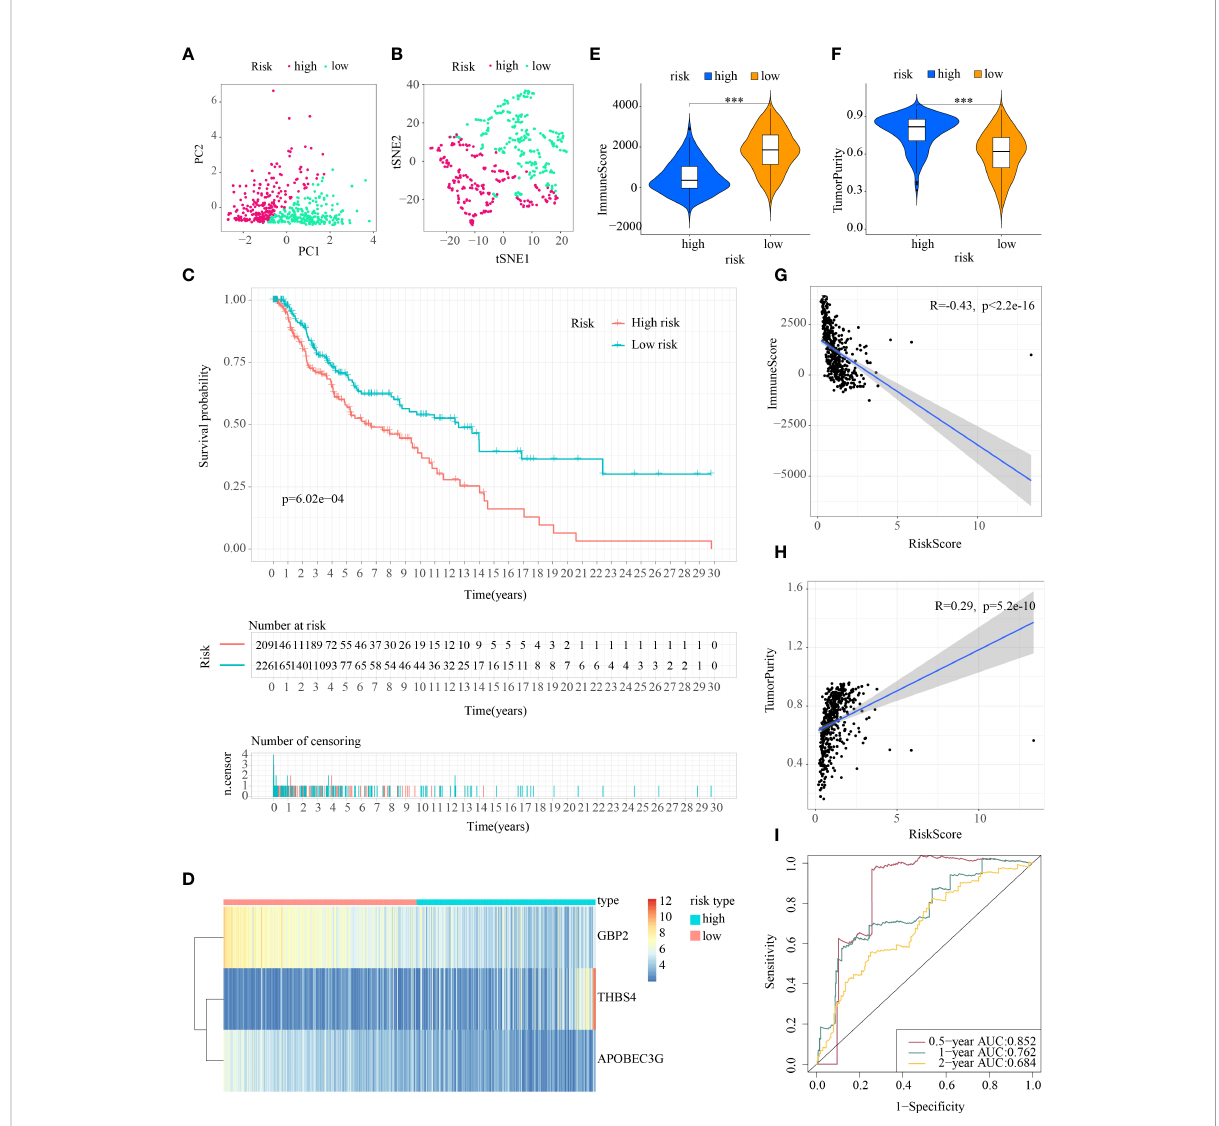
FIGURE 6 Internal veri fi cation of ICDRS in test2 cohort. (A, B) PCA and t-SNE analysis illustrated an excellent clustering performance of the ICDRS-based risk score; (C) Kaplan – Meier survival curves for the overall survival of two risk groups in the test2 cohort; (D) Distribution pattern of the expression levels of the 3 genes in the test2 cohort; (E, F) Comparing TME components in test2 cohort (*** indicates p < 0.001); (G) The correlation between ImmuneScore and risk score; (H) The correlation between TumorPurity and risk score; (I) AUC values of 0.5-, 1-, and 2- year in the test2